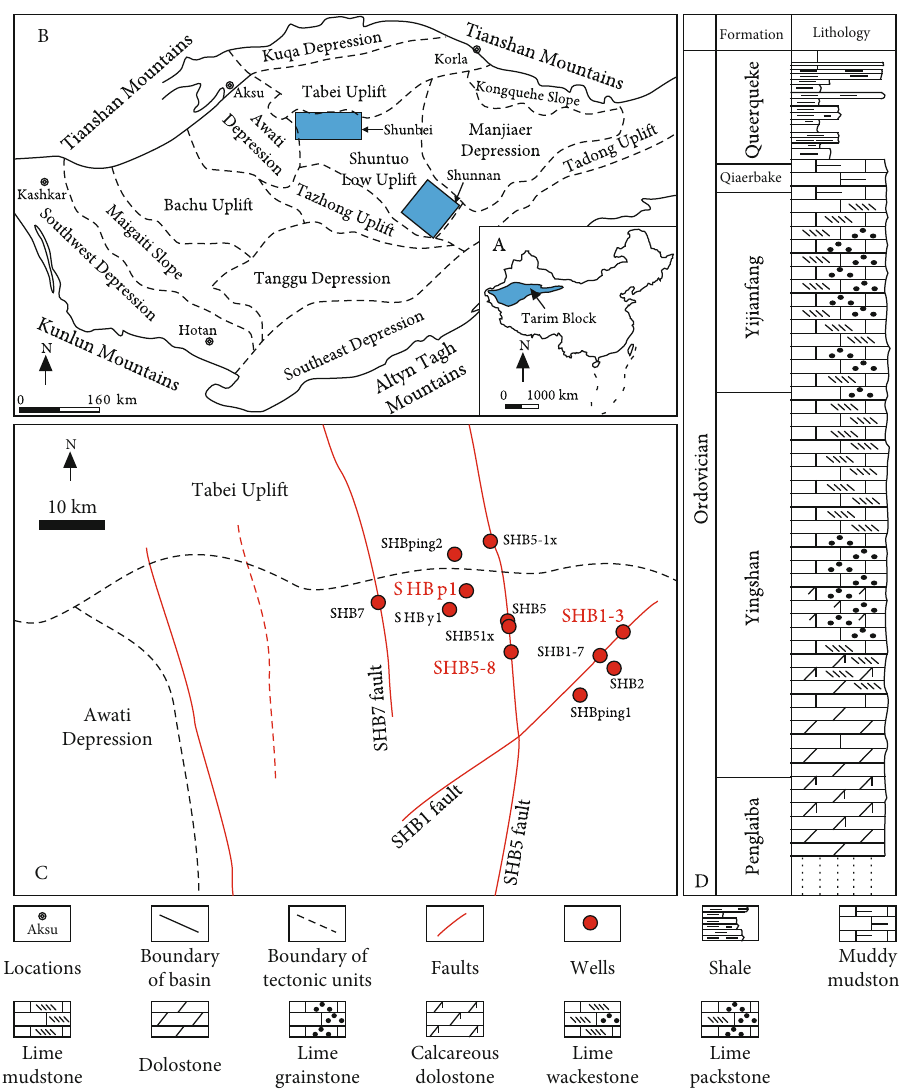
Figure 1: (a) The location of the Tarim Basin in China; (b) the locations of the Shunbei and Shunnan area in the Tarim Basin; (c) the locations of the wells and faults in the Shunbei area; (d) stratigraphy and lithology of the Ordovician succession in the Shunbei area; modi fi ed after Deng et al. [17] and Li et al.